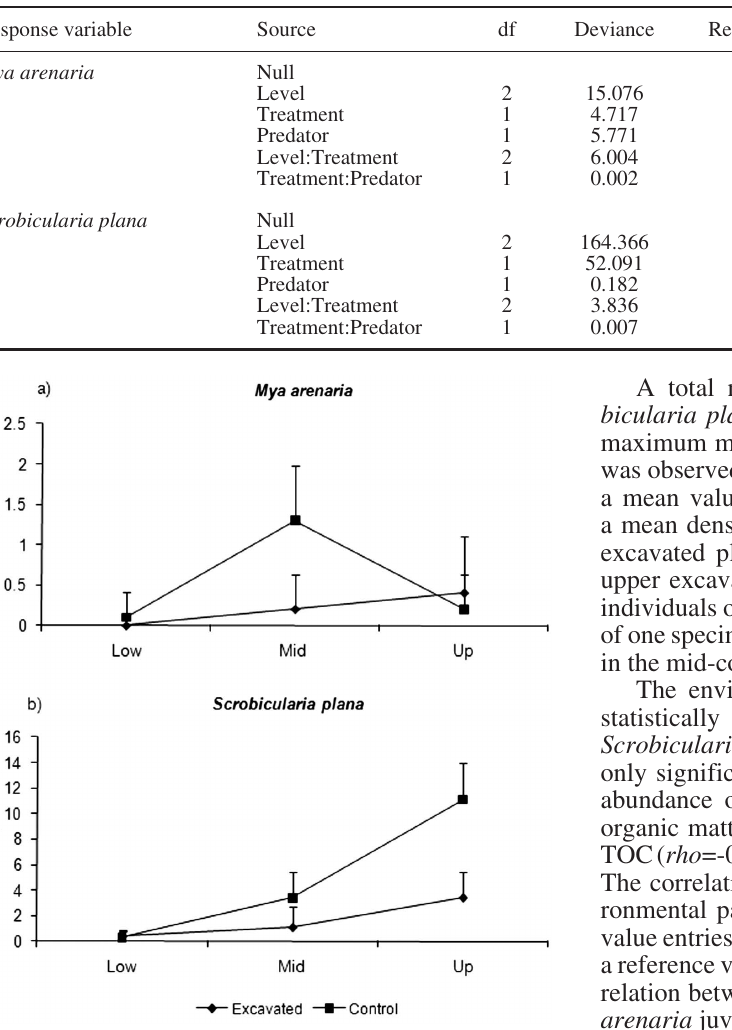
Table 3. – Analysis of deviance testing for the effect of intertidal level, treatment and predators as a covariate on the abundances of Mya arenaria and Scrobicularia plana juveniles as response variables. Significant p -values (P) are in bold.